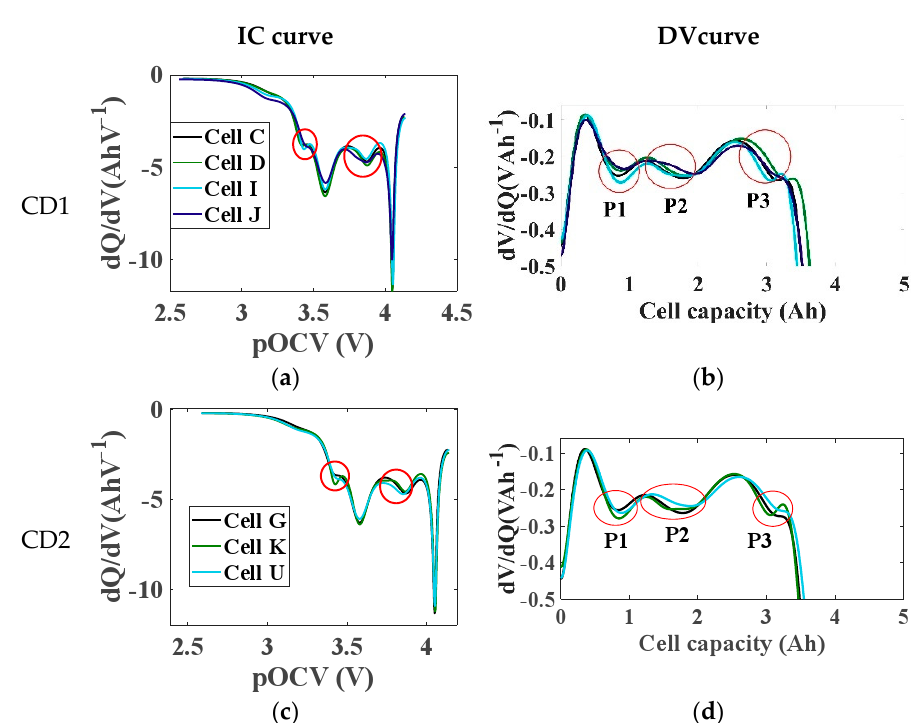
Figure 7. IC-DV curve of the Same DM cell group ( a ) IC ( b ) DV curve of L, M, N & O ( c ) IC ( d ) DV curve of A, B, E & F ( e ) IC ( f ) DV curve of H, P, Q, R, S, T & V. IC curve